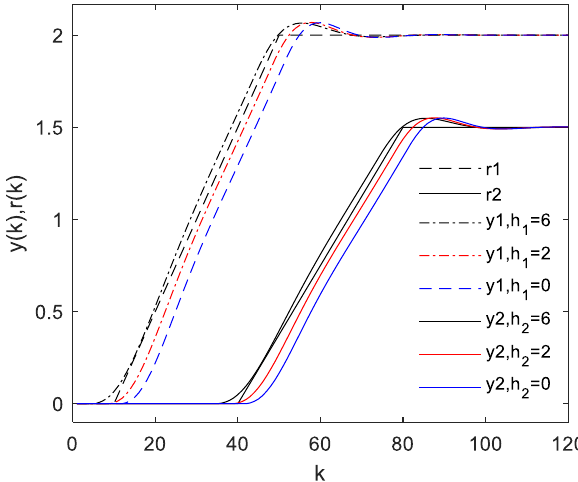
θ = 1, θ = 0, output response of system (1) with di ff erent M 2 1